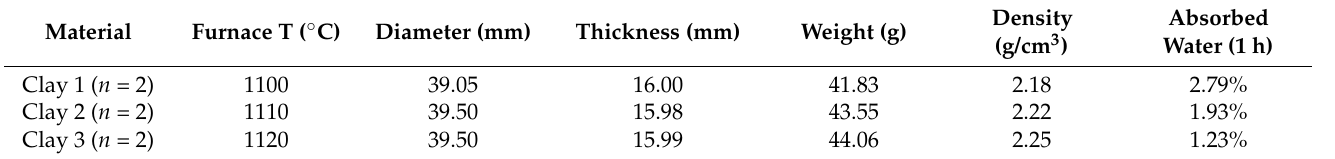
Table 4. Main physical characteristics of tested clay samples ( Clayver data).